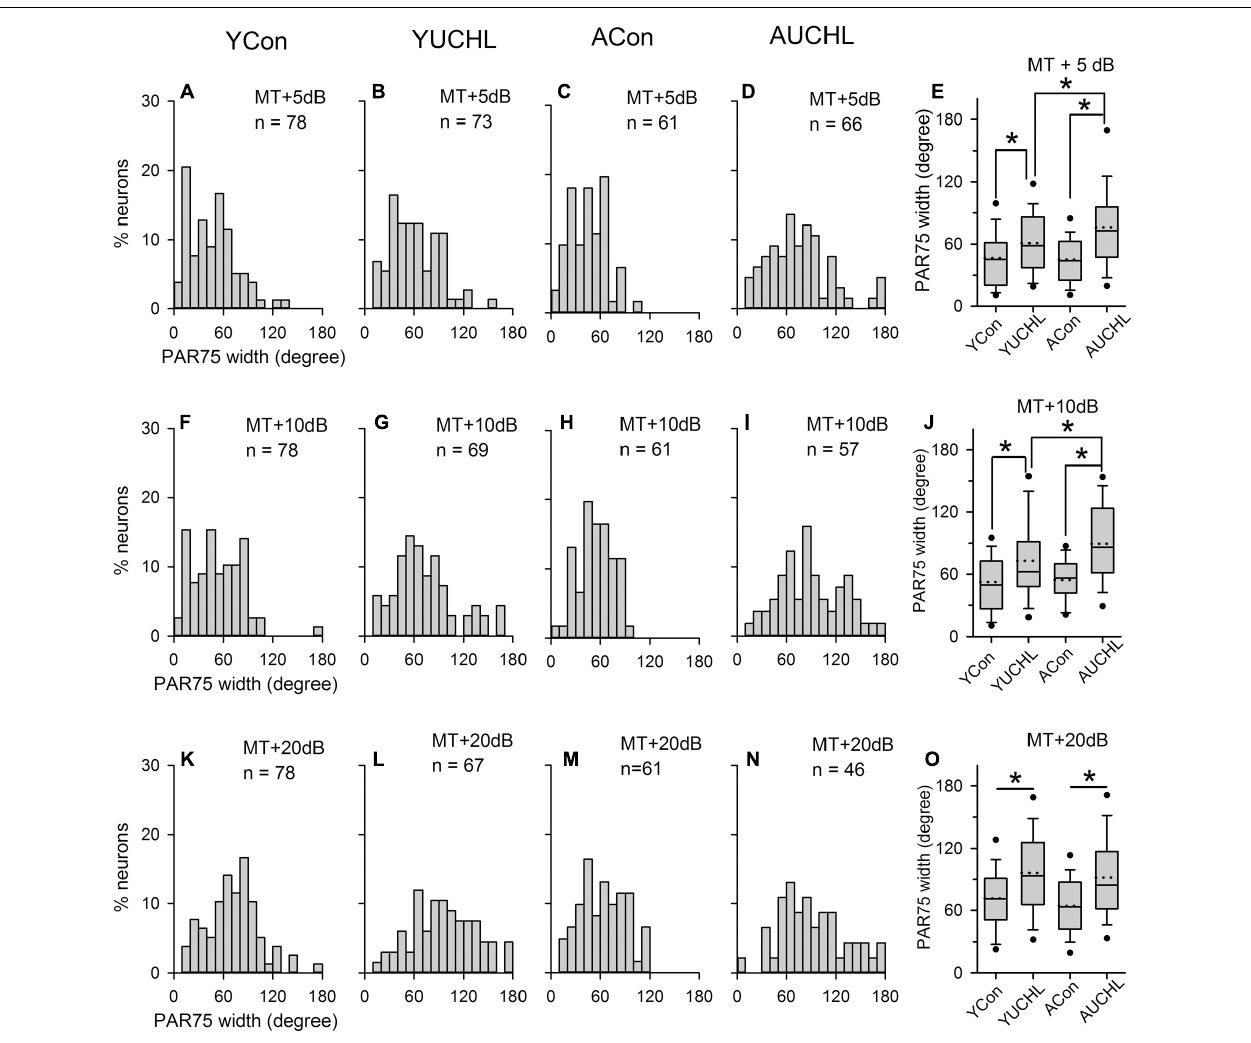
FIGURE 7 | Comparison of the PAR75 width among population of AI neuron from the four groups of rats. The data shown in the panels of the top, middle, and bottom rows are determined at MT + 5 dB (A–D) , MT + 10 dB (F–I) , and MT + 20 dB (K–N) conditions, respectively. Bar histograms show the distributions of PAR75 width of the azimuth functions of A1 neurons from the YCon group (the first column), the YUCHL group (the second column), the ACon group (the third column), and the AUCHL group (the fourth column). (E,J,O) The fifth column box plots of the PAR75 width of A1 neurons in the four groups of rats determined at different sound levels. Each box plot shows the median (solid line in the boxes), mean (dotted line in the boxes), quartiles (box extremities), 10th/90th percentiles (error bars), 5th/95th percentiles (filled circles). ∗ indicates significant difference between the two groups (Mann–Whitney test, p <